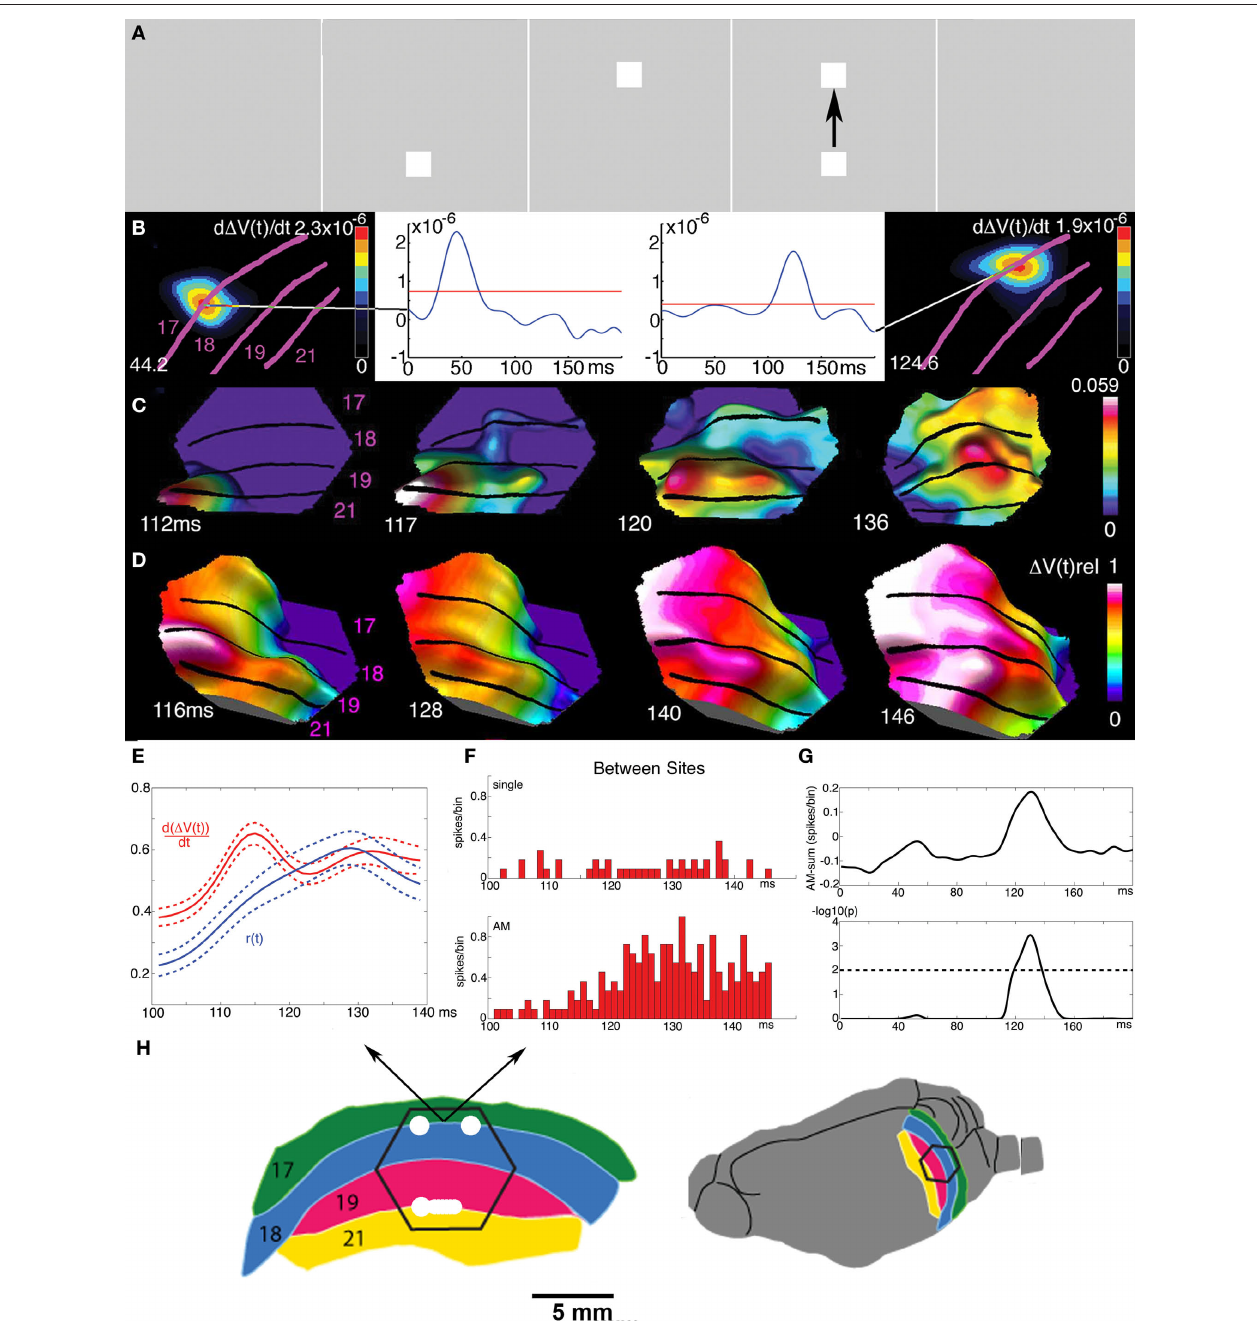
object mappings to the control (only one object flashed at the time at the Figure 11| Cortical spatio-temporal dynamics of the apparent motion corresponding positions) and during apparent motion (AM). (g) Mean illusion. (A) A square is shown to the ferret in quick succession in two difference between the r ( t ) in 10 animals between the apparent motion positions in the field of view, giving the illusion of apparent motion in humans. condition and the sum of r ( t ) in the control conditions (top). Bottom: units firing (B) The square is mapped as increases in d V /d t in the cortex at two distinct m significantly more APs in apparent motion condition, but only just after the FB positions at the 17/18 area border 44.2 and 124.6 ms. (C) At 112 ms a FB from to area 17 and only in between the object mappings shown in B. (H) Cartoon of areas 19/21 exciting the neurons on the way back to area 17, then turning and visual areas 17, 18, 19, and 21 with the mappings of the bottom and top square exciting and firing the neurons in the space in-between the mappings at the (A) in the time interval 100–140 ms. Note that the higher order areas 19/21 in 17/18 border. (D) After this the excitation of areas 17, 18, 19, and 21 progress the apparent motion case enslave areas 17/18 to compute (apparent) object over the cortex in phase. (e) the transverse excitation (d V /d t ) induced by the m motion out of objects initially mapped as stationary objects by the 17/18 FB and the r ( t ) in between the stationary mappings. Average of 10 animals with neurons (modified from Ahmed et al., S.E.M. (F) Firing of a multiunit at the 17/81 border between the stationary